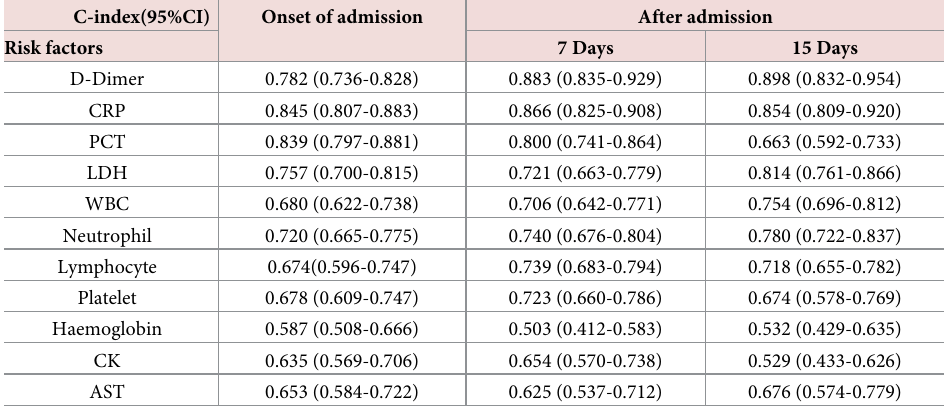
Table 2. C-index analysis of the clinical risk factors to predict the mortality of COVID-19.